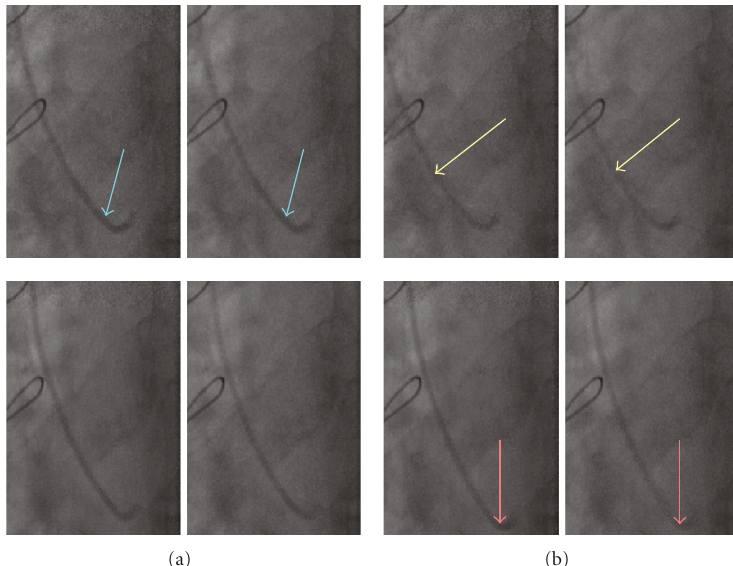
Figure 13: (a) Four-time instants of a fluoroscopic sequence processed with the HR, and (b) the ANMCR filter. We observe a better contrast preservation of the catheter with the hybrid filter.